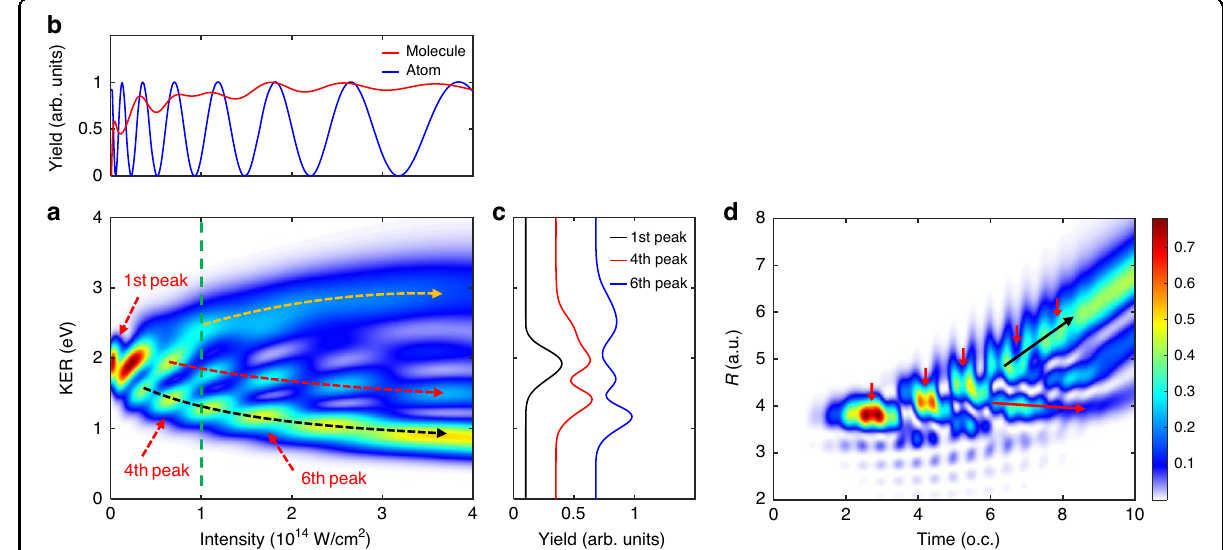
Fig. 3 Verifying rolling and looping dynamics in a multicycle laser pulse. a The simulated KER spectra as a function of the peak intensity of a ten-optical-cycle 400-nm laser pulse. b Populations of the 2 p σ u state after the laser-H 2 + interaction, i.e., the proton yield, as a function of the laser intensity. The red curve is obtained by integrating the two-dimensional map in ( a ) over the whole KER region. The blue curve is numerically simulated by only switching on the dipole transition at R ω . The maxima of both curves are normalized to one for the convenience of comparison. c The dissociation yields as a function of the KER obtained by integrating the two-dimensional map in ( a ) within the laser intensity regions of [0, 1 × 10 12 ], [5 × 10 13 , 9 × 10 13 ] and [1.3 × 10 14 , 2 × 10 14 ] W/cm 2 , corresponding to the 1st, 4th and 6th peaks, respectively. d Temporal evolution of the density distribution of χ u calculated with the laser intensity I 0 = 1 × 10 14 W/cm 2 , labeled by the green dashed line in ( a ). The fi ve small red arrows denote that the outward NWP undergoes fi ve Rabi oscillations. The initial state in the calculation is the v = 6 vibration